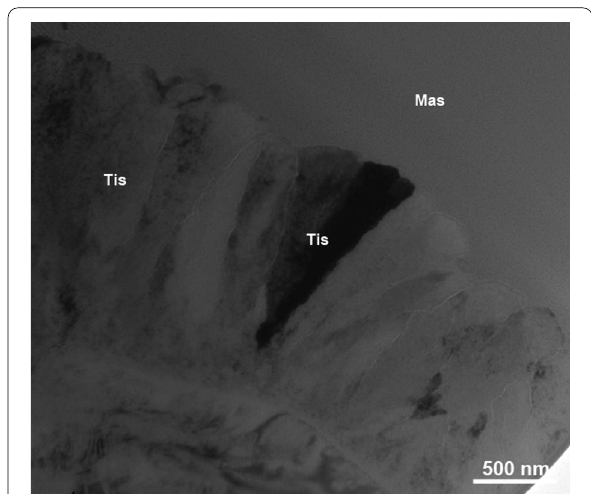
Fig. 9 BF-TEM image of tissintite in the shergottite Tissint. Spherulitic tissintites have occurred in an original plagioclase grain in contact with the melt-pocket of Tissint. The interstices are filled with amorphized plagioclase (probably because of melting). Tis: Tissintite, Mas: